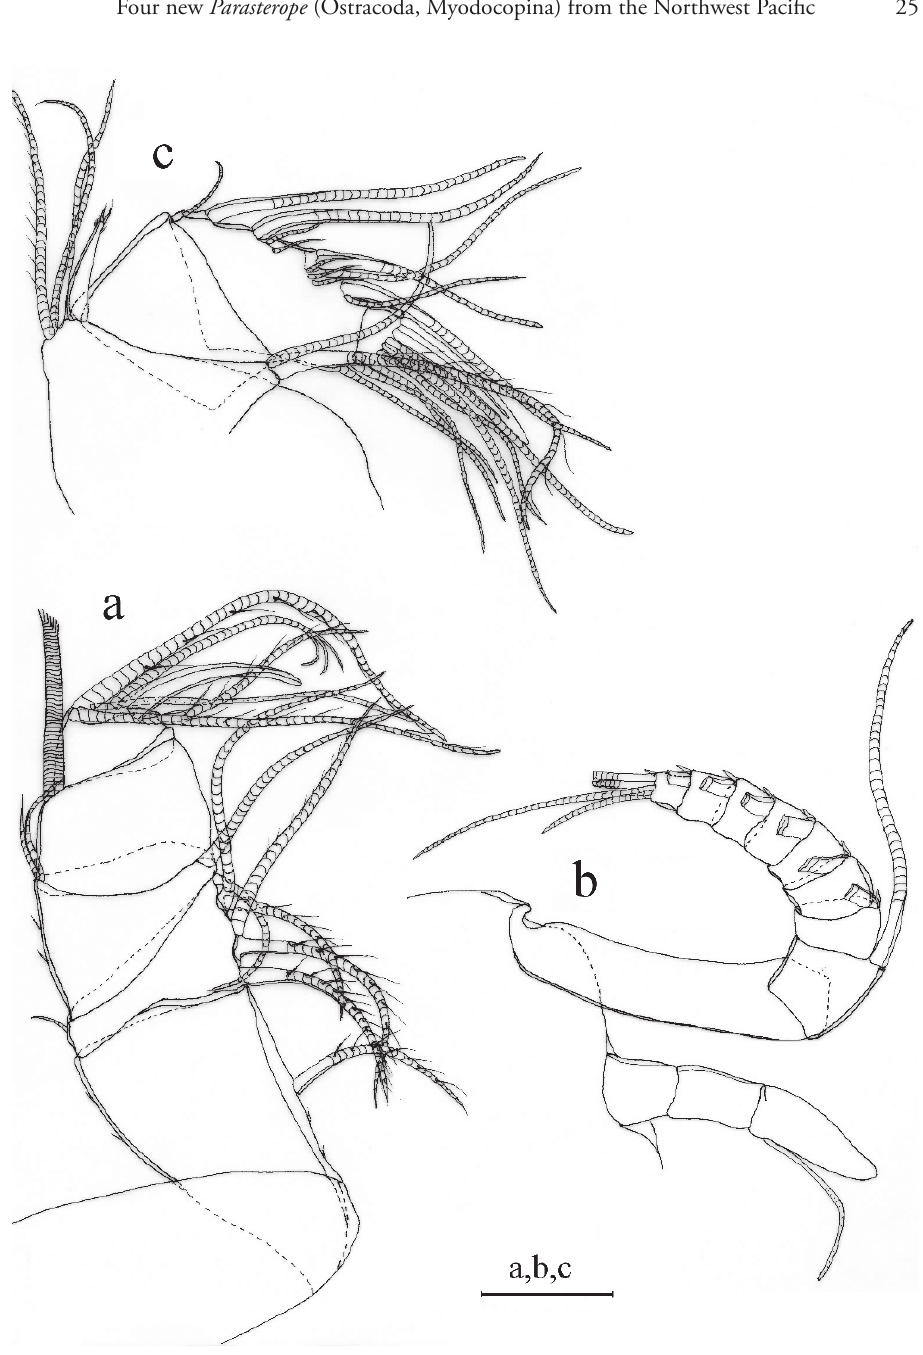
Figure 6. Parasterope sagami sp. nov. holotype female adult: a A1 b A2 c Md. Scale bar: 0.1